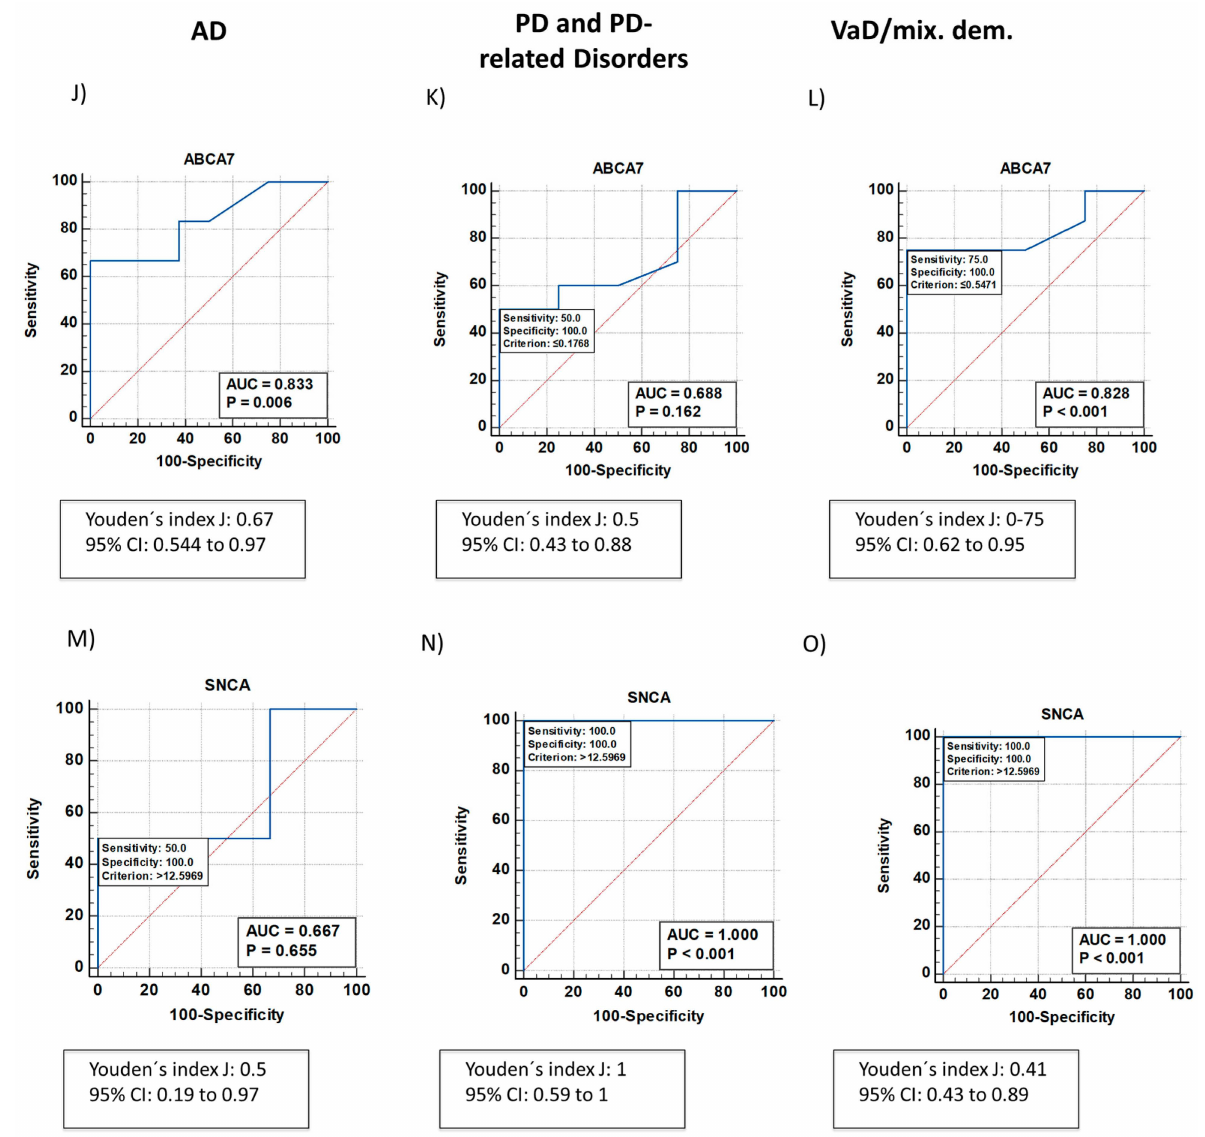
Figure 2. ROC curve analysis of mRNA expression data from buffy coat samples from patients with AD, PD and PD-like disorders, and VaD/mixed dementia. ROC curve analysis of APOE ( A – C ), PSEN1 ( D – F ), PICALM ( G – I ), ABCA7 ( J – L ) and SNCA ( M – O ) mRNA expression from healthy ( n = 9) subjects and patients with AD ( n = 7; ( A , D , G , J , M )), PD and PD-related disorders ( n = 14; ( B , E , H , K , N )), and VaD/mixed dementia ( n = 13; ( C , F , I , L , O )). The optimal cutoff values derived from the Youden’s J index are indicated below each graph. The red diagonal line is the ROC curve reference line. p values were calculated using Delong’s test; p < 0.05 was considered statistically significant. 95% confidence interval, 95% CI; AD, Alzheimer’s disease; ABCA7, ATP-binding cassette, subfamily A, member 7; APOE, apolipoprotein E; AUC, area under the curve; PD, PD, Parkinson’s disease; PICALM, phosphatidylinositol-binding clathrin protein; PSEN1, presenilin-1; ROC, receiver operating characteristic; SNCA, alpha synuclein; VaD, vascular